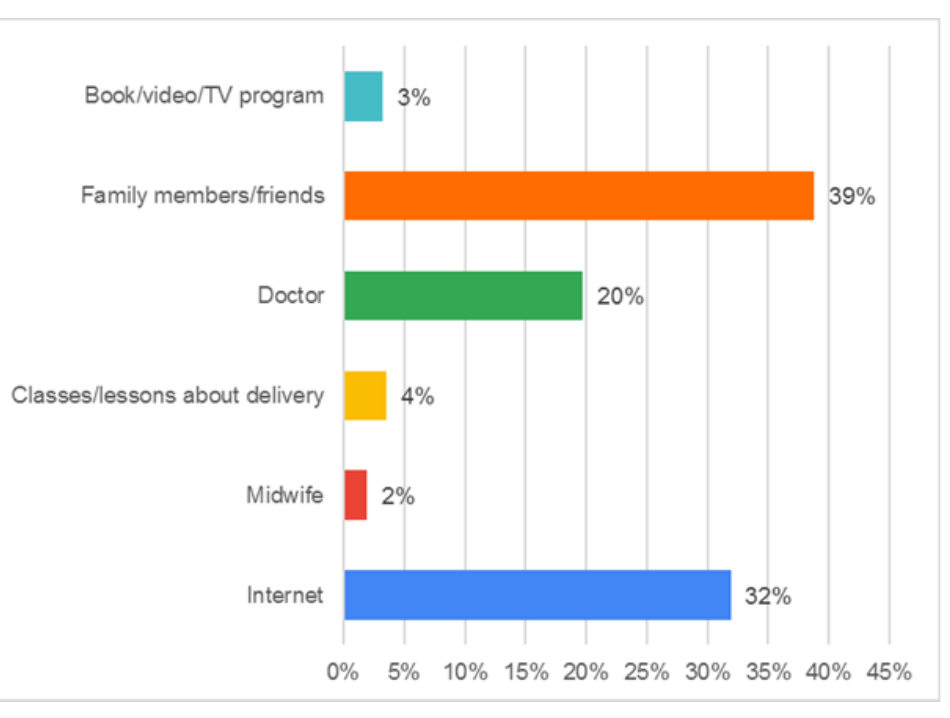
Figure 1. Source of information about EA as reported by the study participants .